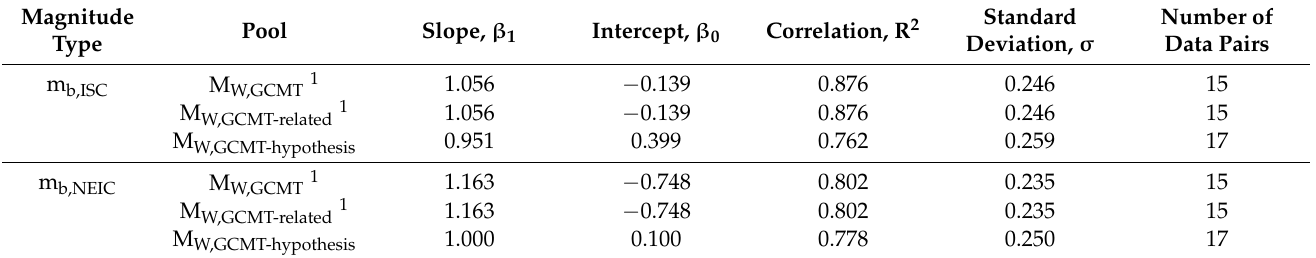
Table 10. Magnitude homogenization regression results from all moment magnitude pools for body wave magnitude types.